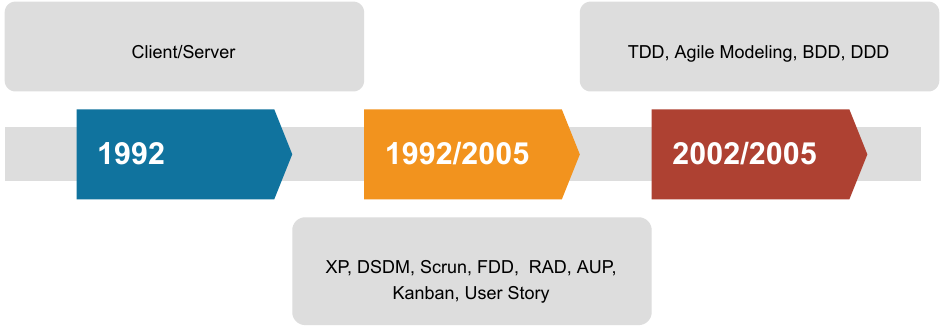
Figure 1. Agile-Architecture